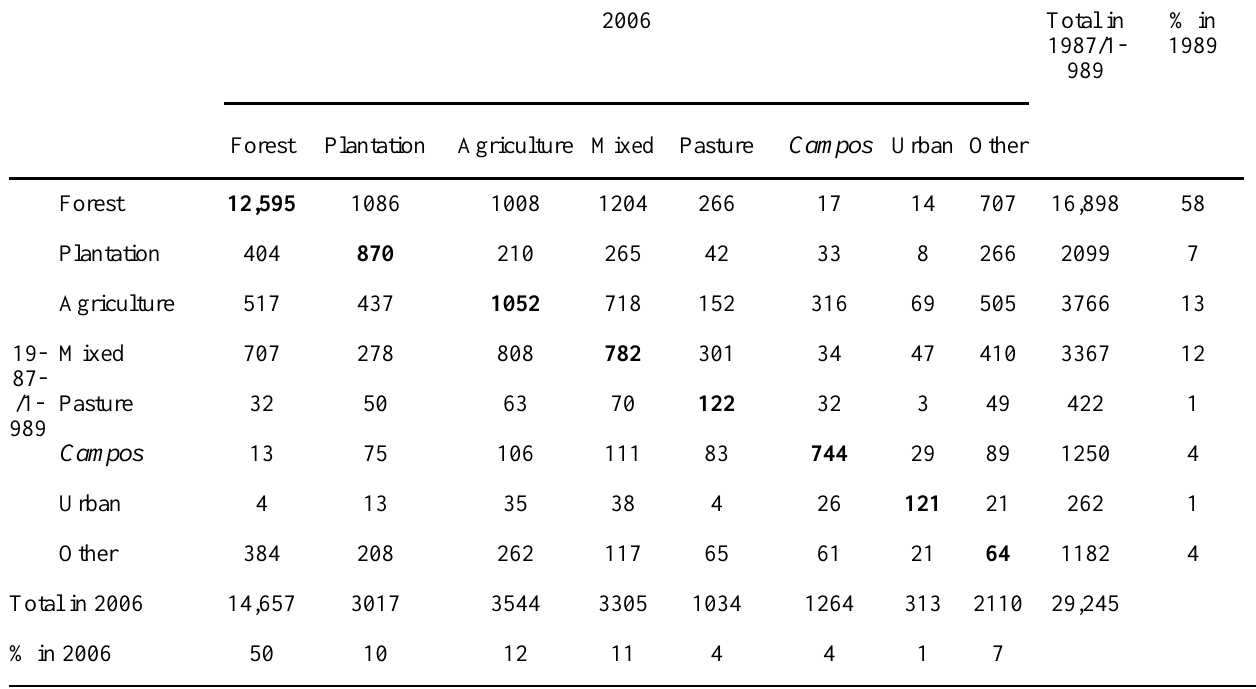
Table 3. Land-use transition matrix for the period of 1989–2006. Rows represent the source land-use category in 1987/1989 (top) and the status of the areas in 2006 (bottom). Columns represent the fate land- use categories in 2006 (left) and the status of the areas in 1987/1989